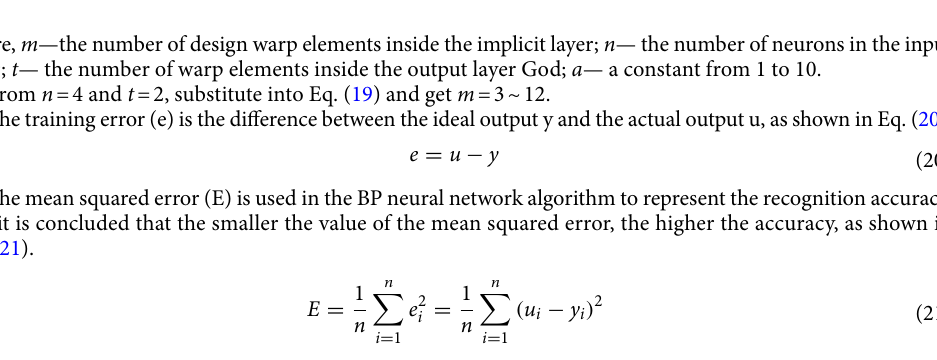
Figure 15. Error of different nodes within the hidden